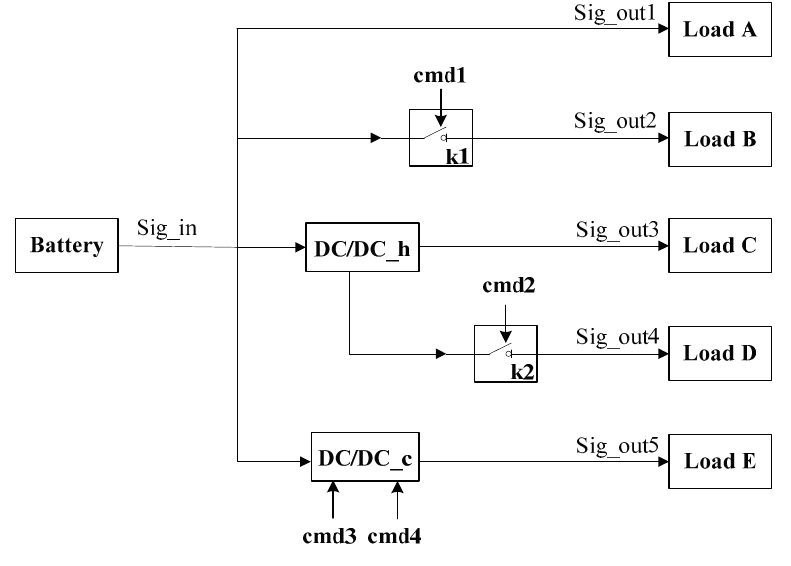
Figure 5. Selected subset of the power supply control unit.